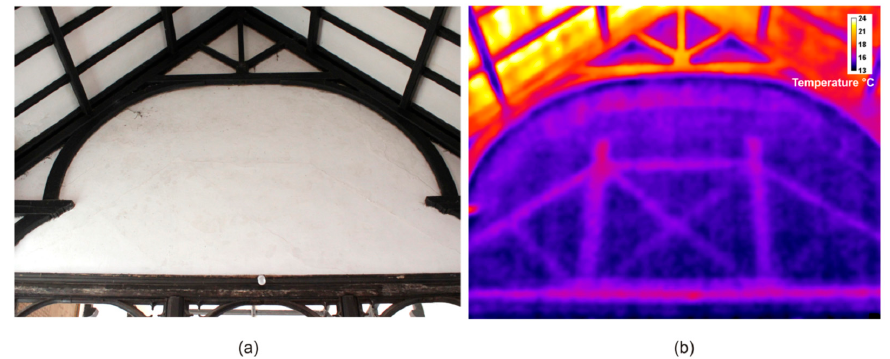
Figure 3. Winkburn church, Nottinghamshire, U.K., the east side of the chancel screen, ( a ) under normal lighting (daylight), as seen by the unaided eye, and ( b ) in the thermal infrared with low level Wallis filtration applied.